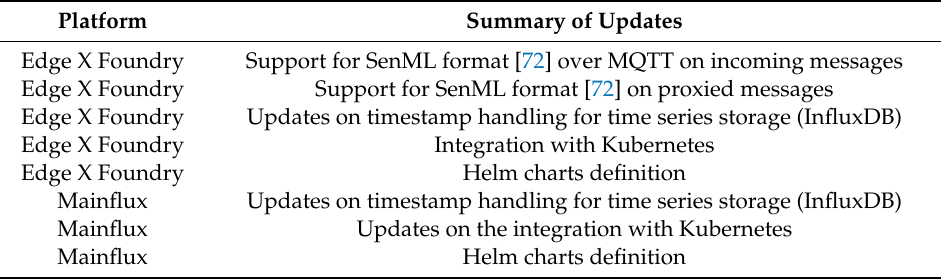
Table 1. Main software updates done on Edge X Foundry and Mainflux